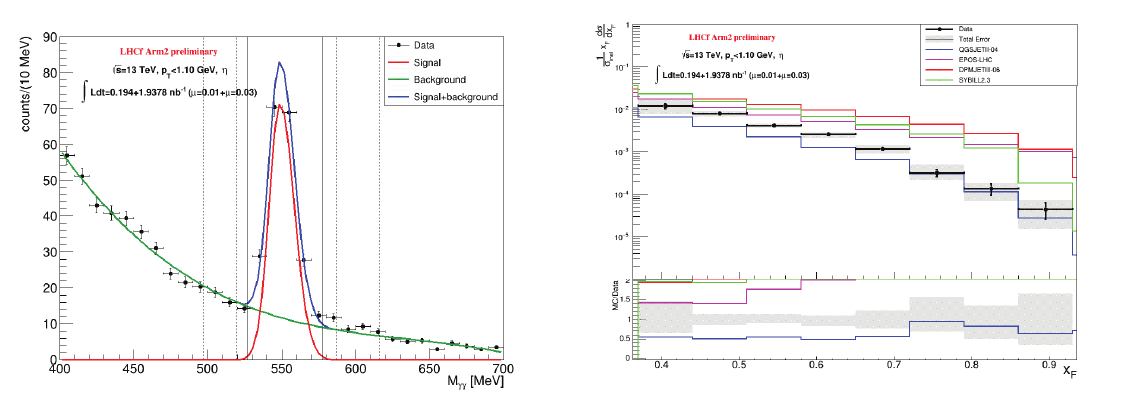
Figure 1. (left) Invariant mass distribution reconstructed from two photons [10]. (right) Production cross-sections of η meson